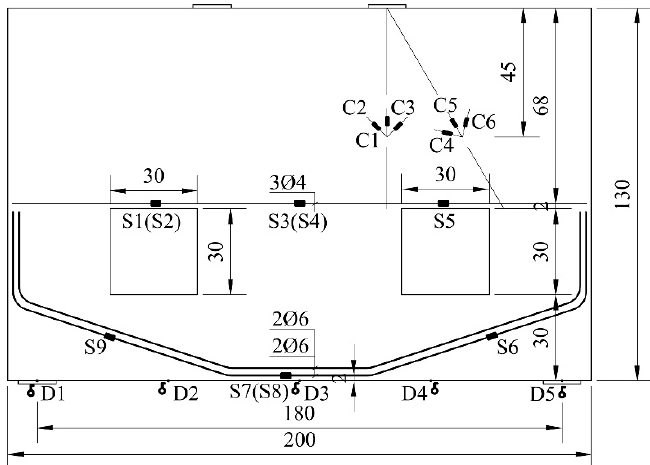
Figure 10. ( a ) Hydraulic press with force sensor, ( b ) hand pump for load application. Appl. Sci. 2020 , 10 , x FOR PEER REVIEW